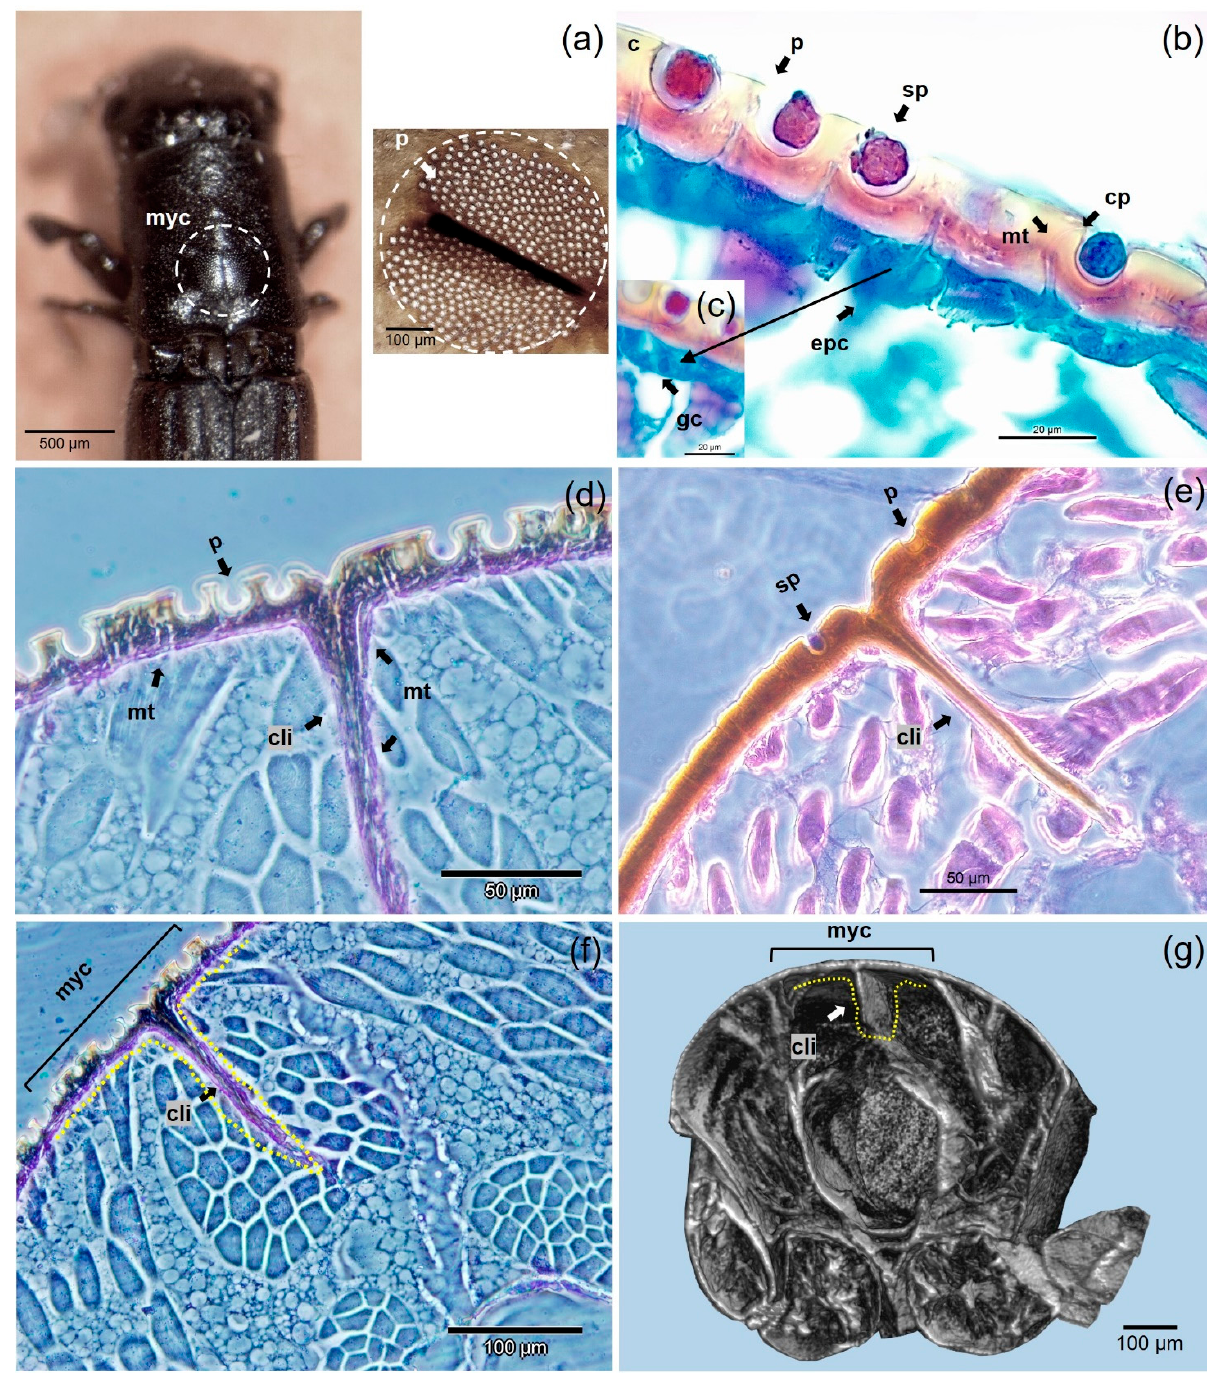
Figure 5. Morphological view of the prothoracic mycangia of P. cylindrus adult beetles: ( a ) magnification of a female mycangia with a stereo microscope (scale bars = 500 and 100 µm); 2D histological sections ( b – d , f ) of a female (scale bars = 20, 50 and 100 µm, respectively) and ( e ) of a male (scale bar = 50 µm); ( g ) 3D reconstruction of a female mycangia based on µ-CT scans (scale bar = 100 µm). Abbreviations: c, cuticle; cp, cuticular pore; cli, cuticular layer invagination; epc, epithelial cell; gc, glandular cell; myc, mycangia; mt, microtubule; p , pits; sp, spores.